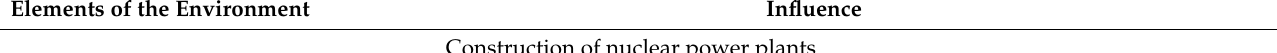
Table 3. Impact on selected elements of the environment on some alternative branches of the energy sector [18]. Elements of the Environment